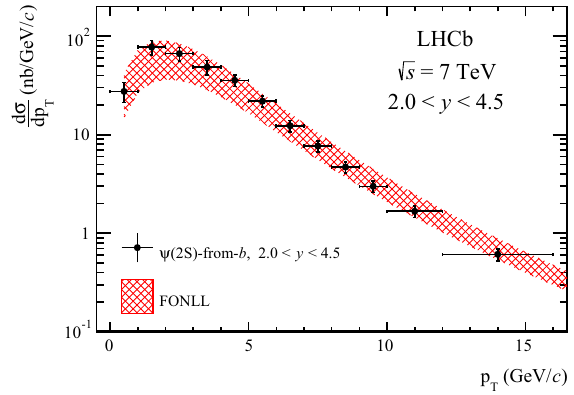
Fig. 3 Pseudo-decay-time t z distribution for the ψ( 2 S ) → μ + μ − decay mode in the range 4 < p T ≤ 5 GeV/ c , showing the background and prompt contributions